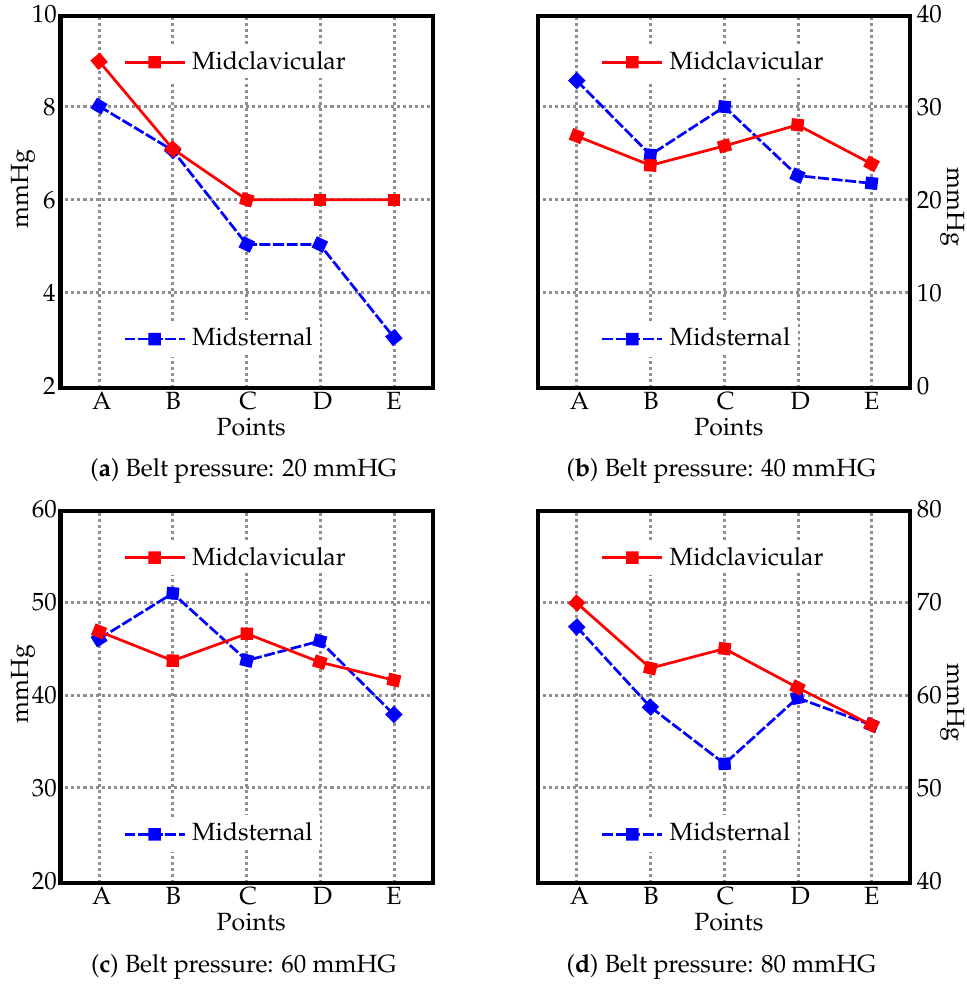
Figure 2. The pressure values [mmHG] along the midsternal and midclavicular lines at different points (see Figure 1) with the belt inflated to ( a ) 20 mmHG, ( b ) 40 mmHG, ( c ) 60 mmHG, and ( d ) 80